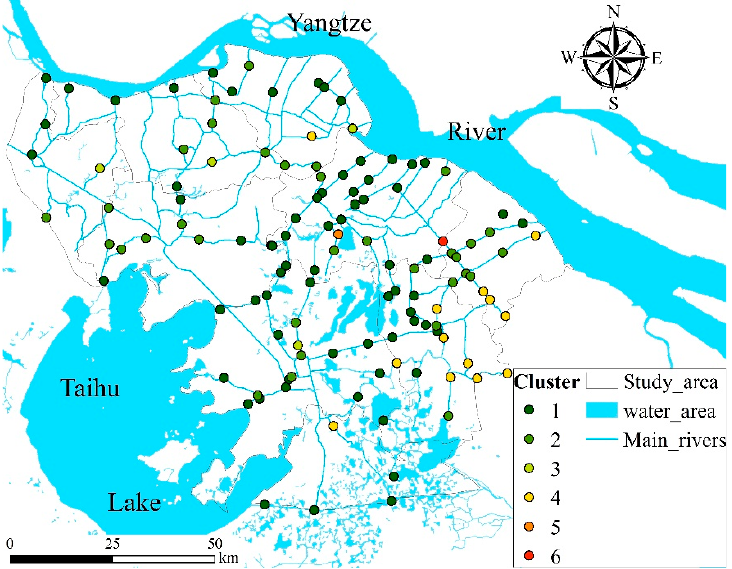
Figure 5. Clusters divided by hierarchical clustering of sites in the Jiangsu Taihu Plain, with samples from 2010 to 2014.